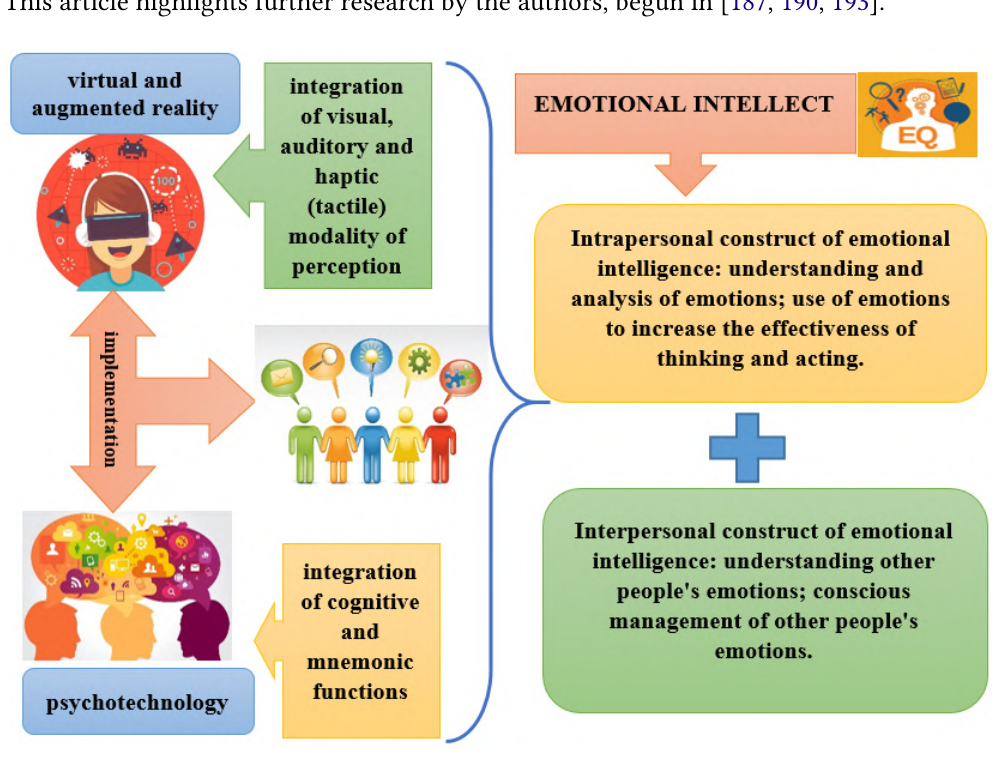
Figure 84: Presentation of paper